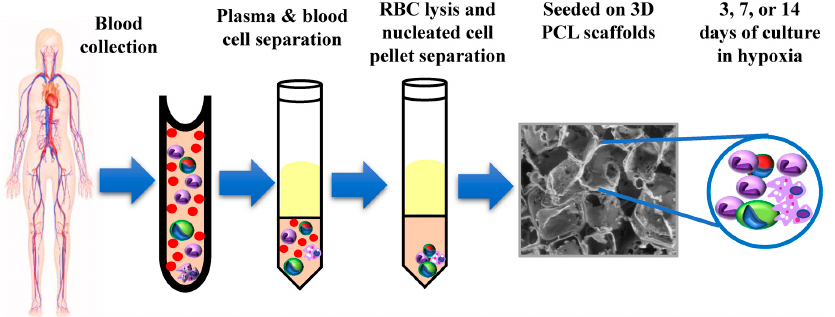
Figure 1. Workflow of culturing breast cancer patient blood-derived cells in 3D poly( ε -caprolactone) (PCL) sca ff olds. Schematic showing the culture method of breast cancer patient blood samples for culturing circulating tumor cells